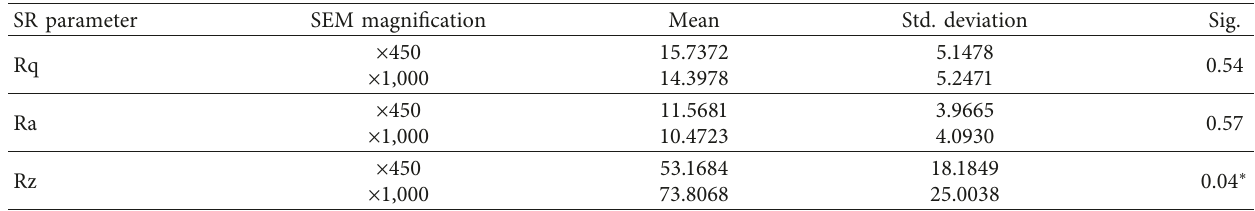
Table 3: SR parameters recorded under × 450 and × 1,000 magnification ( ∗ p < 0 .